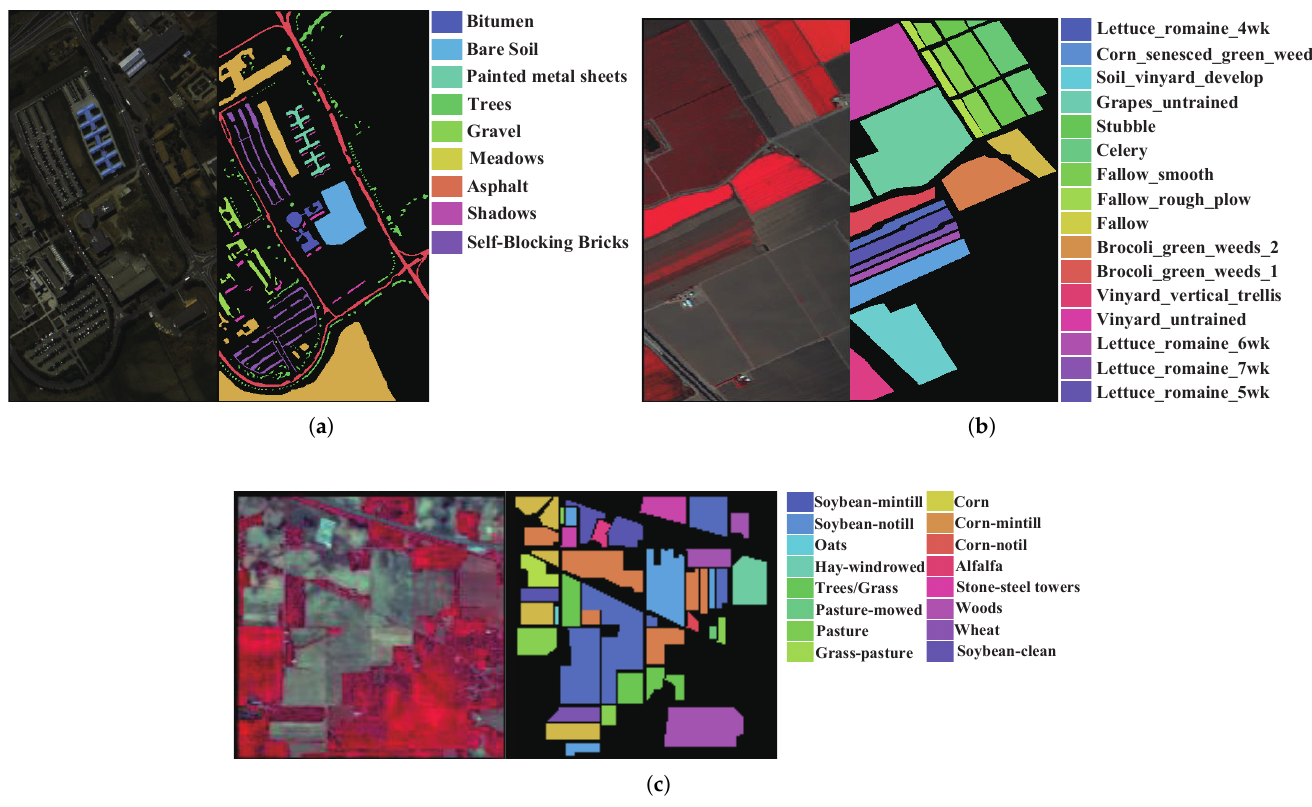
Figure 4. The false-color maps and ground-truth maps of three data sets. ( a ) Pavia University data set, ( b ) Salinas data set, ( c ) Indian Pines data